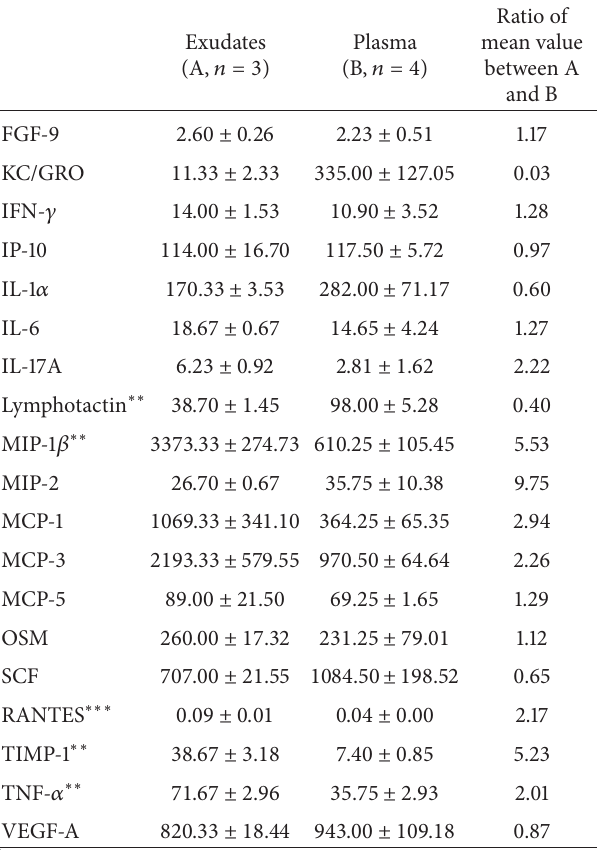
Table 1: Concentrations and ratios of inflammatory mediators in exudates and plasma on day 1 after thioglycollate treatment in vivo ∗